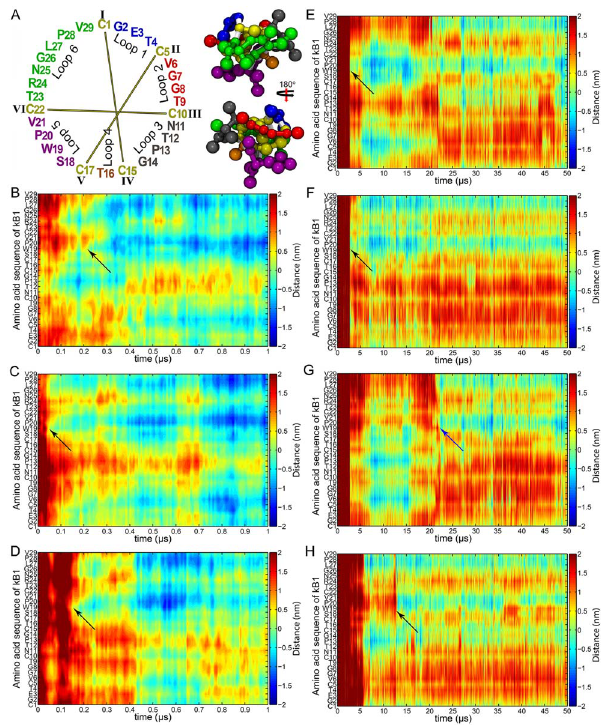
Figure 1. Membrane binding progression of kB1. (A) Sequence and coarse-grained model of kB1 structure. The amino acid (AA) sequences of kB1 and other cyclotides are divided into six loops. Loops 1–6 of kB1 are colored blue, red, grey, orange, violet and green, respectively. Cysteine is shown in yellow and disulfide bonds are presented with yellow lines. The structure of kB1 is shown as a space-filling CPK model. The loop colors are the same as those shown for the sequence. The peptide bond of any AA residue to cysteine is shown in white. The distances of all AA residues relative to the membrane surface of the monomer in the (B) M1, (C) M2 and (D) M3 simulations are presented. The relative distances are shown during 0–1 m s to clearly demonstrate the activity of Trp19 in the membrane binding process of kB1. The distances of all AA residues of kB1 molecules (E) A, (F) B, (G) C and (H) D in the tetramer relative to the membrane surface during the entire simulations are shown. Black arrows show the membrane binding of Trp19. The blue arrow shows the binding of the Trp19 of molecule C to the membrane at approximately 22.3 m s, which was the time that the tetramer completed its membrane binding